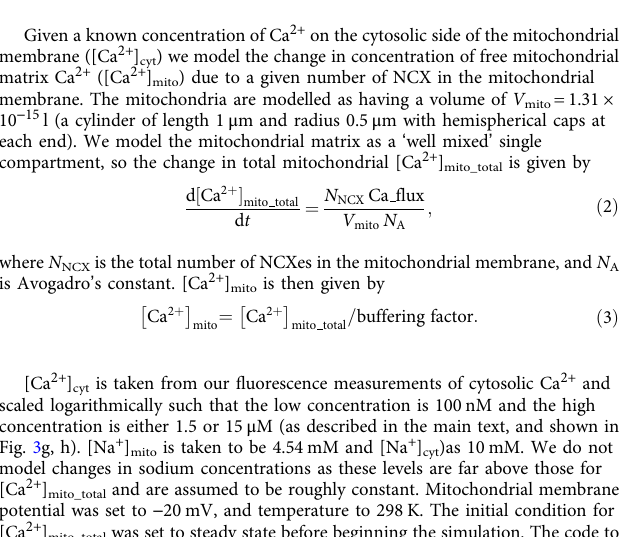
Given a known concentration of Ca 2+ on the cytosolic side of the mitochondrial membrane ([Ca 2+ ] cyt ) we model the change in concentration of free mitochondrial matrix Ca 2+ ([Ca 2+ ] mito ) due to a given number of NCX in the mitochondrial membrane. The mitochondria are modelled as having a volume of V mito = 1.31 × 10 − 15 l (a cylinder of length 1 μ m and radius 0.5 μ m with hemispherical caps at each end). We model the mitochondrial matrix as a ‘ well mixed ’ single compartment, so the change in total mitochondrial [Ca 2+ ] mito_total is given by d Ca 2 þ ½